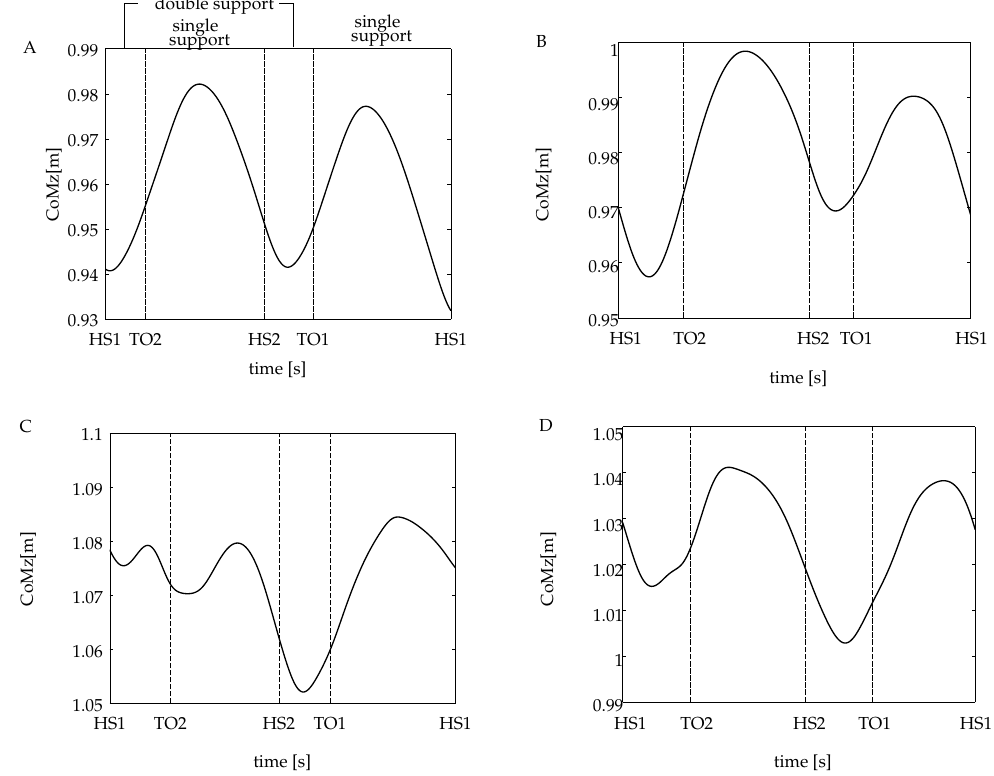
Figure 4. Vertical displacement of the CoM for ( A ) the non-amputee and ( B – D ) the amputees’ volunteers. HS 1 and HS 2 correspond to heel strike events of the trailing and the leading leg, respectively. The TO 1 and TO 2 are toe-off events for the same legs. For the case of the amputee subjects, the trailing leg corresponds to the intact leg.